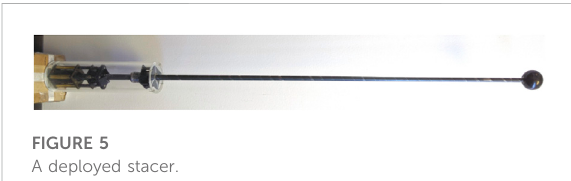
FIGURE 5 A deployed